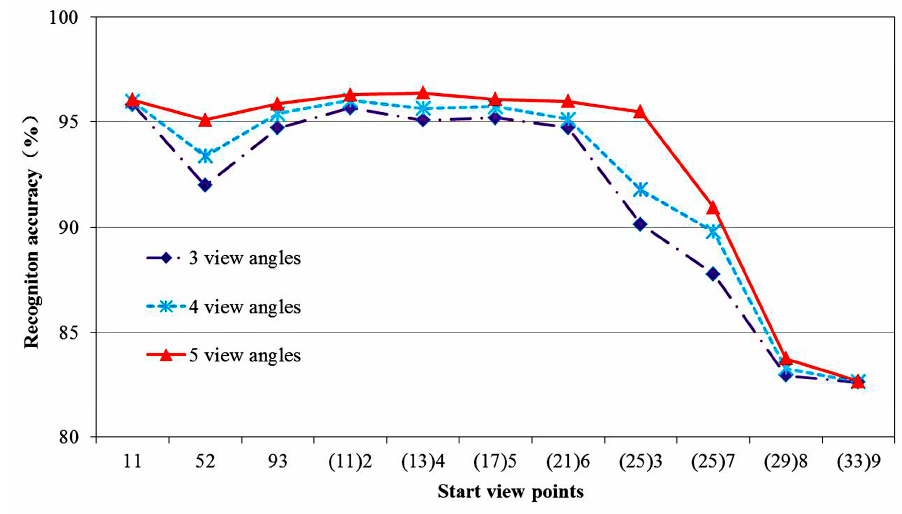
Figure 15. Recognition performance with different start points and view angles.